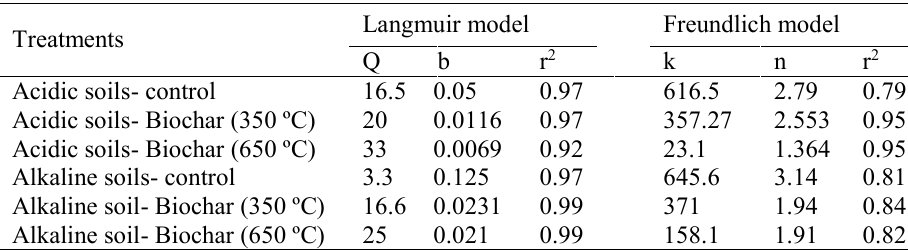
Table 6. The desorption isotherm models and its coefficients